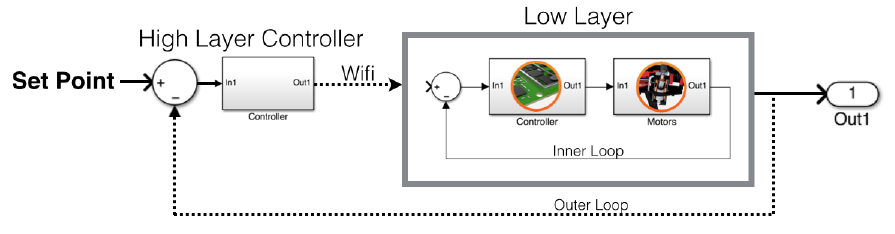
Quadrotor layers: the low layer represents the electronic assistance and the embedded operative system on the AR.Drone; the high layer represents the pilot (natively a smart device i.e. ,